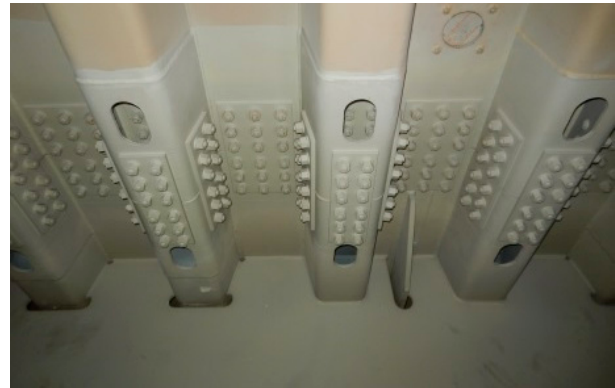
Figure 1. The bolted splicing part in the box girder of a bridge.